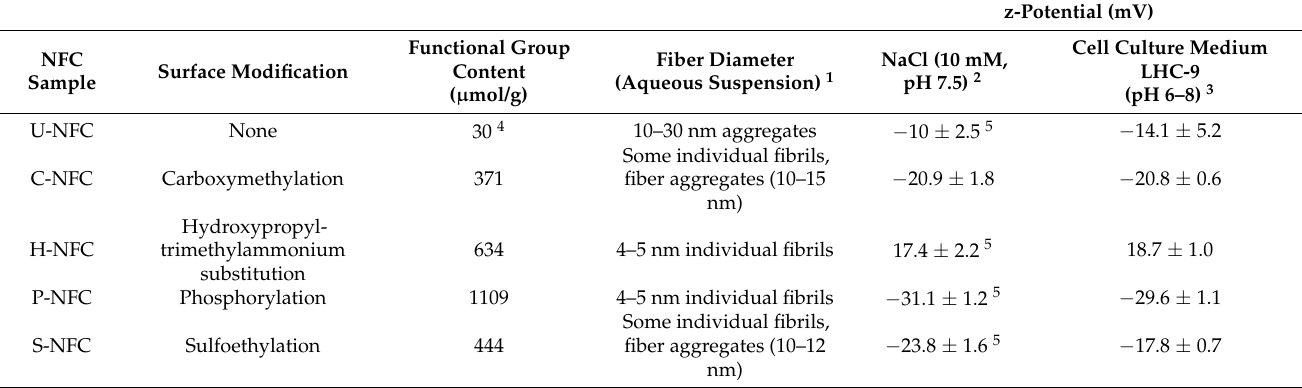
Table 1. Properties of the nanofibrillated cellulose (NFC) materials under